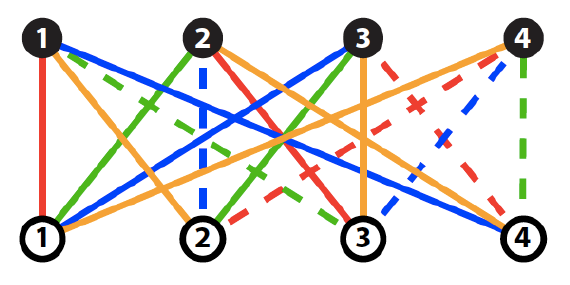
Figure 1 . A \valise"